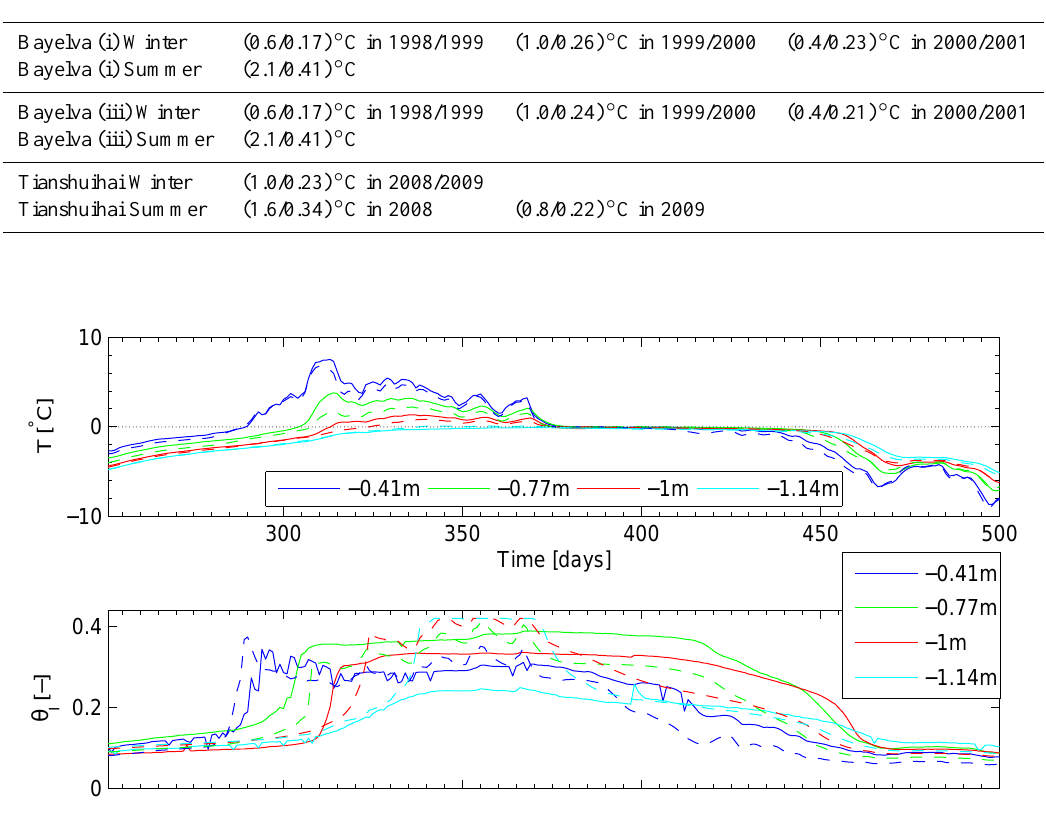
Fig. 7. Measured (solid) and simulated (dashed) temperature and liquid water content for the Bayelva simulation with conductive and convective transport by liquid water and water vapor (scenario (i)). The data show the period from 22 May 1999 to 27 January 2000. The probes at 1.14 m depth are situated right at the edge of the thaw depth, here a slight misestimate of the thaw depth can be seen clearly in the liquid water content for days 340 to 380.